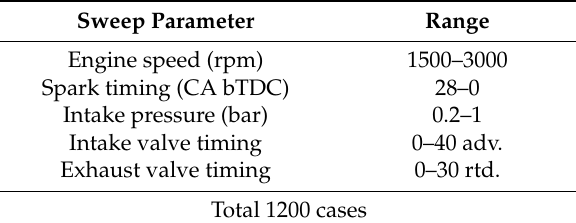
Table 5. Sweep parameters and ranges of the Dessign of Experiment (DoE) process.